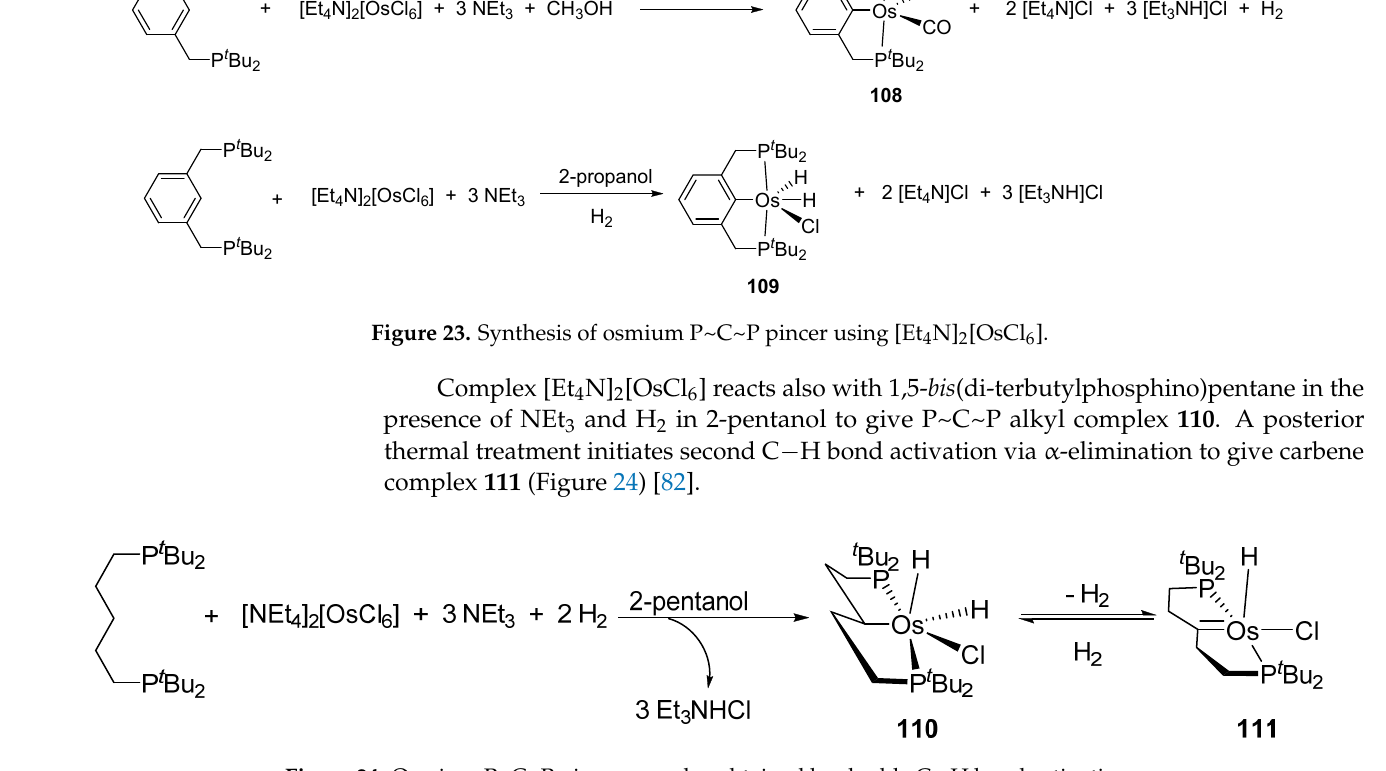
Figure 24. Osmium P~C~P pincer complex obtained by double C − H bond activation.